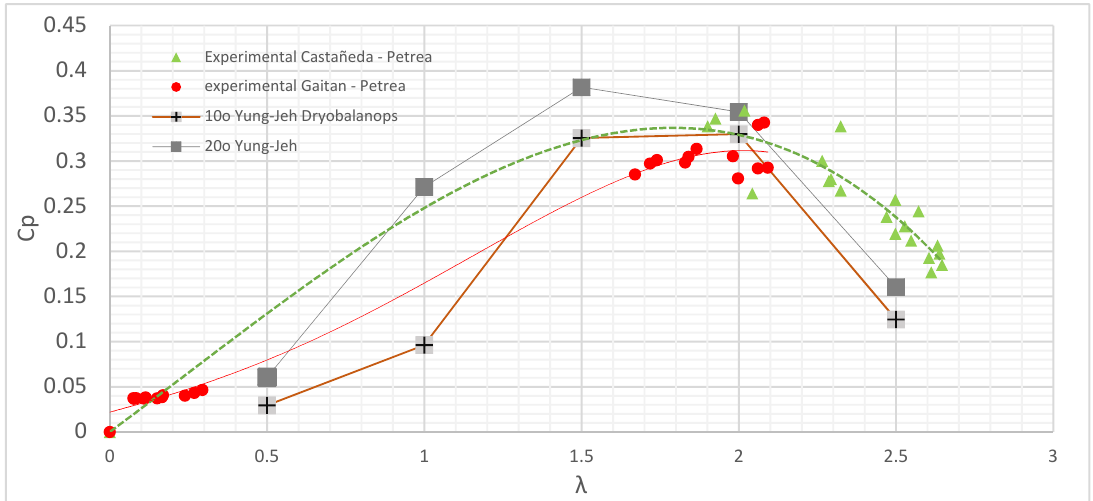
Figure 18. Experimental results for Petrea seed and Biomimetic rotor 3 blades Dryobalanops (10o means 10 degrees for blade pitch angle).